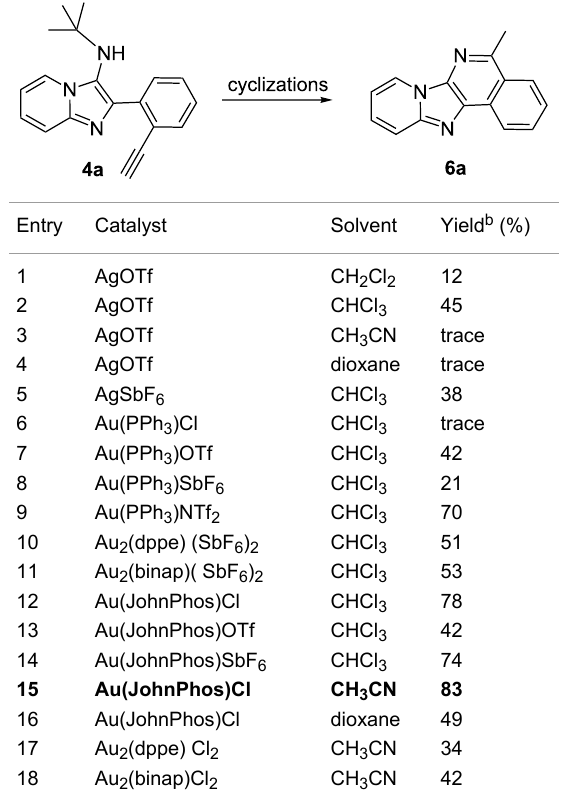
Table 1: Optimization of the cyclization reaction conditions.